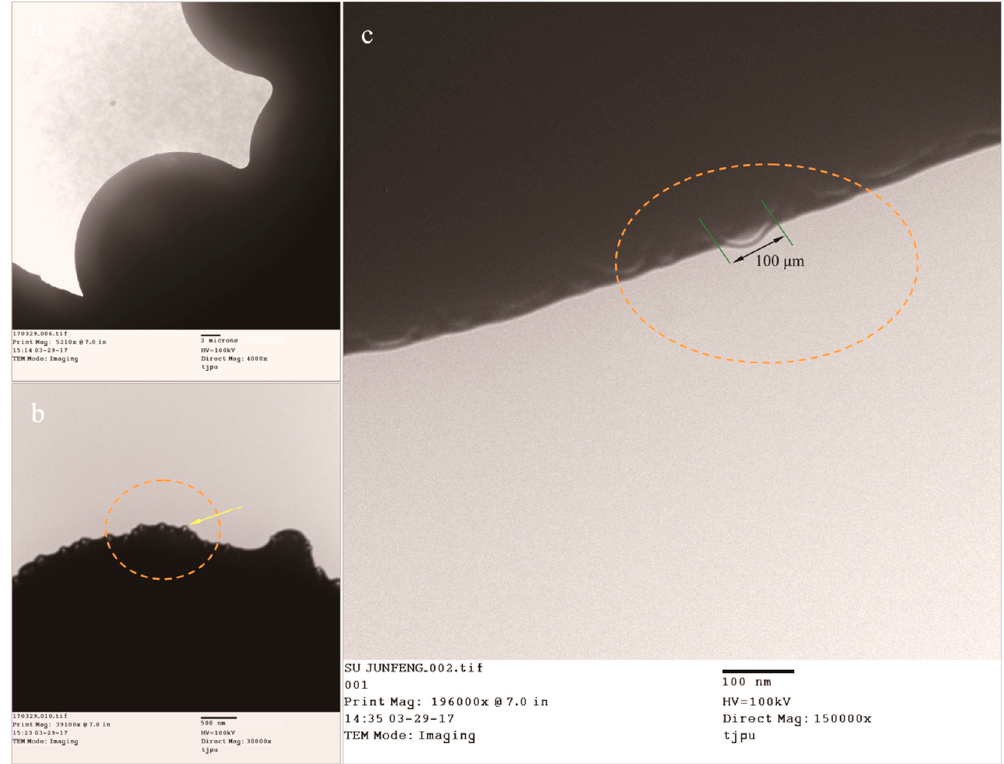
Figure 6. Transmission electron microscopy (TEM) morphologies of the microPCMs sample (MG-2), ( a ) the microPCMs particles on a copper screen; ( b ) a hybrid shell surface with graphene; and ( c ) typical graphene extending out of the shell surface (100 nm).